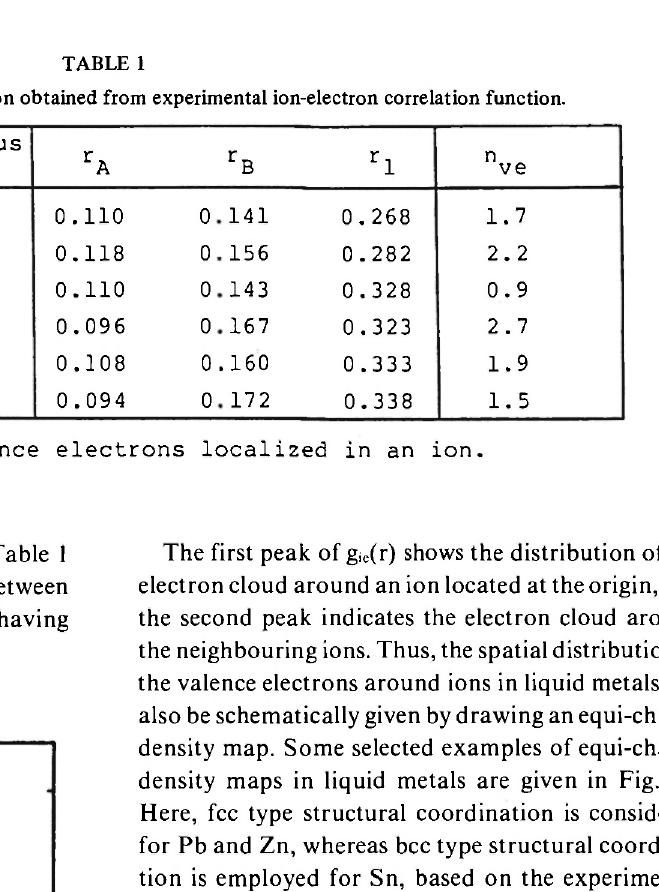
Ionic radius rj and its relevant information obtained from experimental ion-electron correlation function. r . 1